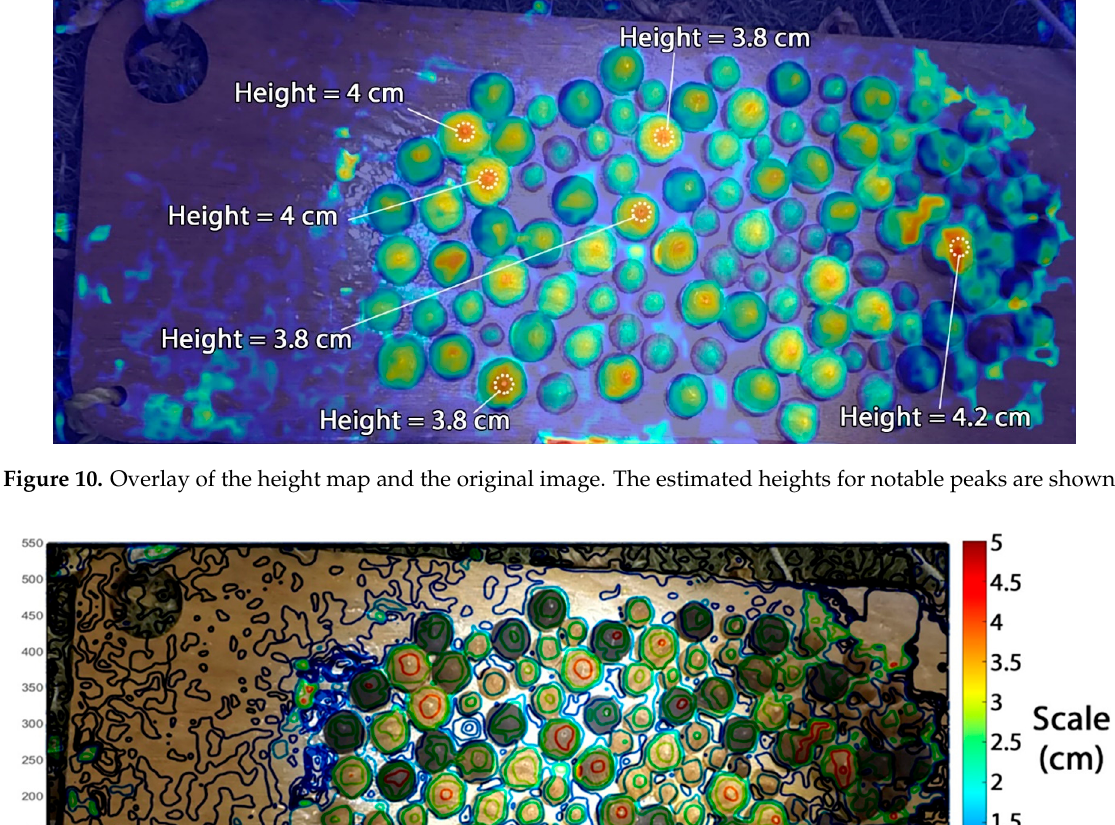
Figure 9. Scaled height map of the artificial specimen relative to the board (the elevation of the board is set to 0 cm).